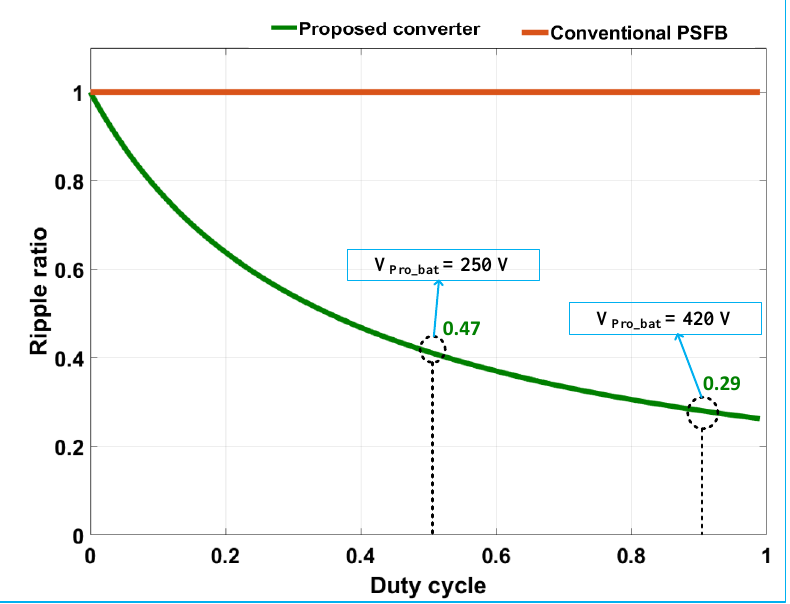
Figure 9. The ratio of the current ripple of the proposed converter compared to the conventional topology.